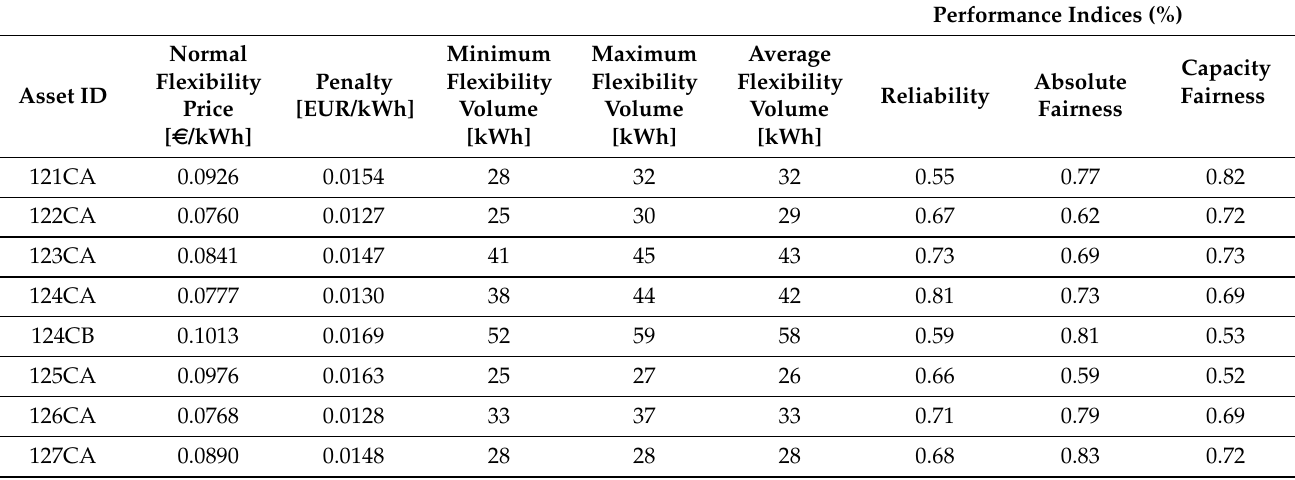
Table 2. Overview of assets associated with the local congestion